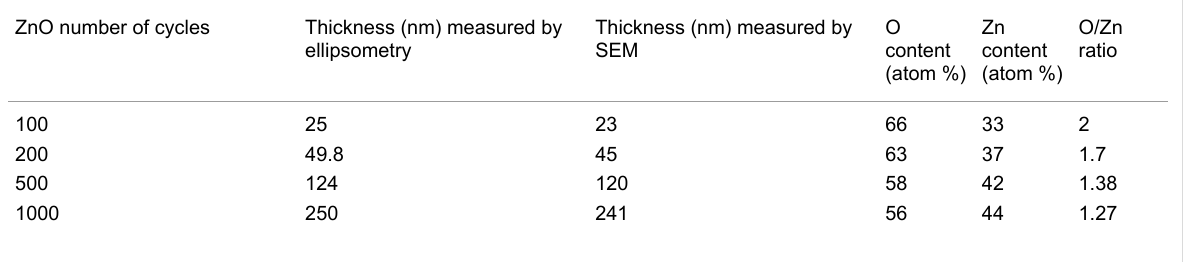
Table 1: Thickness of ZnO thin films measured by SEM and ellipseometry. Content of Zn and O estimated from EDX analysis. ZnO number of